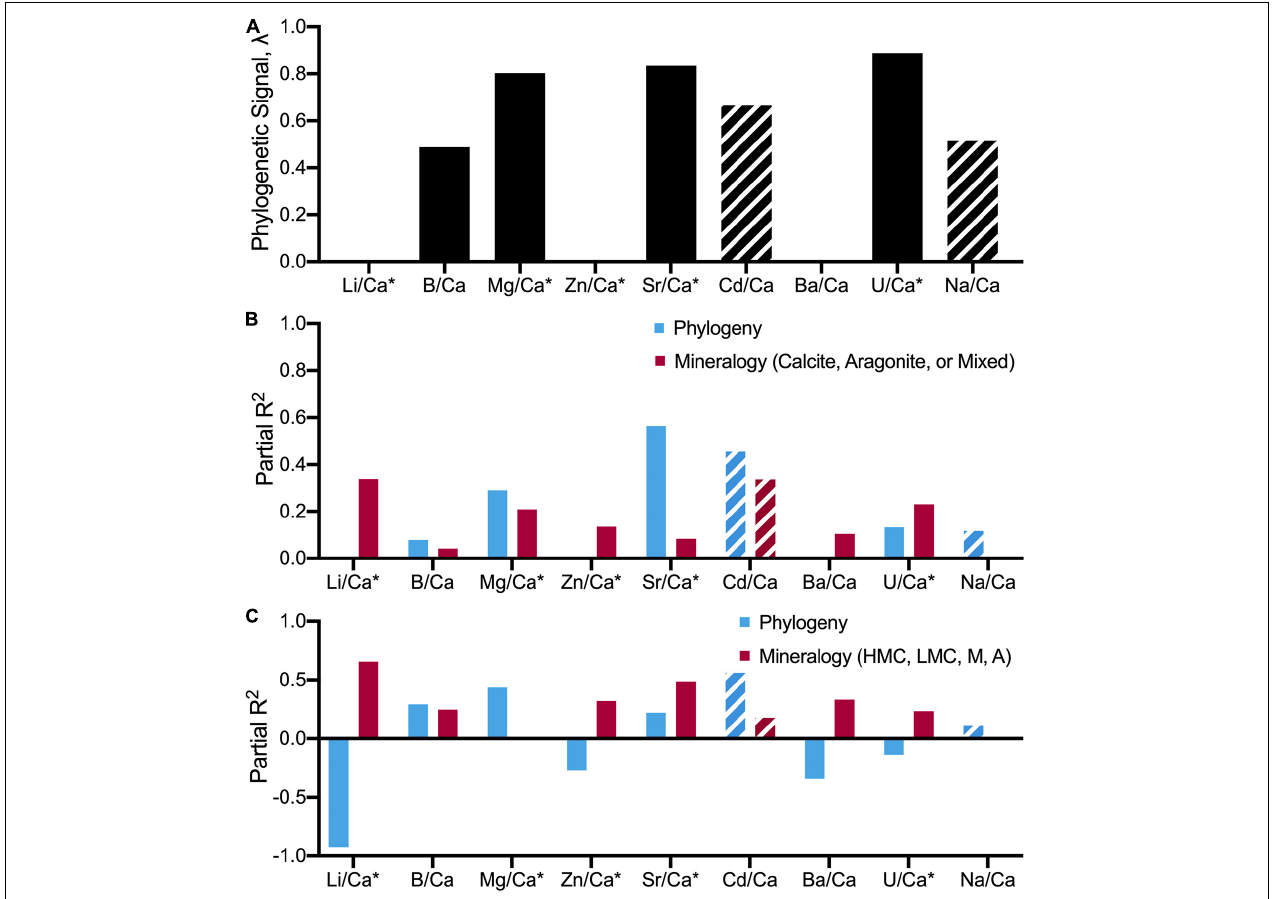
FIGURE 7 | Estimated relative contributions of phylogeny and mineralogy on X/Ca ratios using phylogenetic and non-phylogenetic models on the full species-level dataset. (A) Bar graphs illustrating the phylogenetic signal, λ , (B,C) relative contributions of evolutionary history (phylogeny) and mineralogy on differences in X/Ca ratios among 18 focal species. Partial R 2 s for each predictor within each given element-to-calcium ratio follow Ives (2018) and Ives and Li (2018). Full results are provided in Supplementary Table 9 . “*” denotes elemental ratios that have three or less values imputed. Mg, Sr, Li, and Zn datasets have zero imputed values. Striped bars denote elemental ratios (Cd and Na) that consider five or more imputed values, potentially influencing the resulting λ and R 2 . The difference between graphs (B,C) are how mineralogy was defined for the analysis: (B) Mineralogy is categorized as whether an organism produces calcite or aragonite, or a mixture of the two; (C) Mineralogy is broken down further, categorizing mineralogy as HMC, high-Mg calcite; LMC, low-Mg calcite; A, aragonite; or M, mixture ( Table 1 ). The high phylogenetic signals and high partial- R 2 Phylogeny values deconvolve phylogenetic and mineralogical impacts on the elemental ratios, highlighting the importance of considering phylogeny when assessing elemental ratio